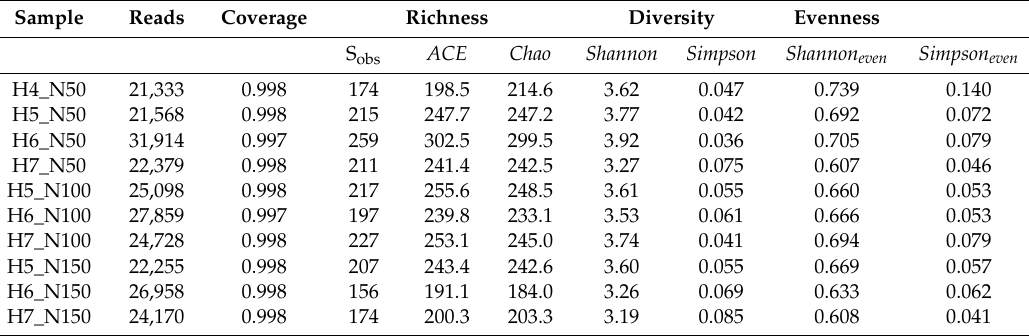
Table 3. Analysis of adequacy of sampling and richness and diversity of the microbial